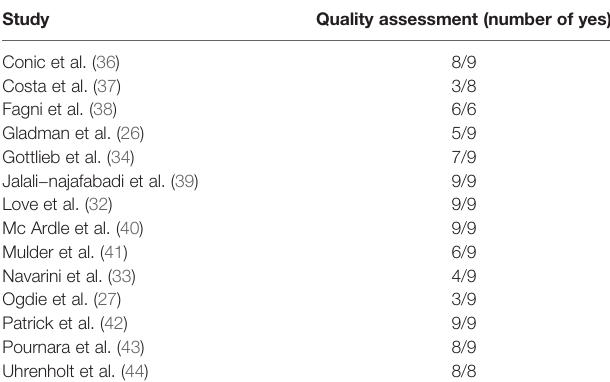
TABLE 3 | Methodological quality assessment of the studies retained in the present systematic literature